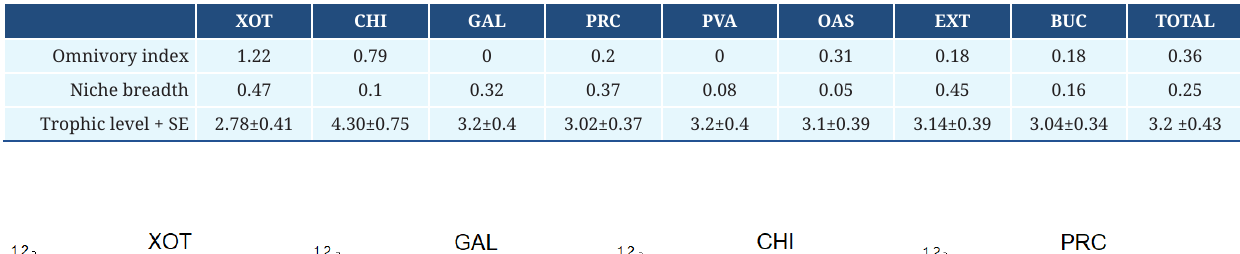
TABLE 4 | Values of omnivory index (Values near to 0 indicates that the fish feed on few trophic levels, values near to 1 indicates that the fish feed on several trophic levels), Niche breadth (BA> 0.60 denotes generalist fish, BA<0.6 denotes specialist fish) and Trophic level of Pseudoxiphophorus bimaculatus in all sampling sites. XOT=El Xote; GAL=Los Galvanes; CHI= El Charco del Ingenio; PVA=Paso de Vaqueros;